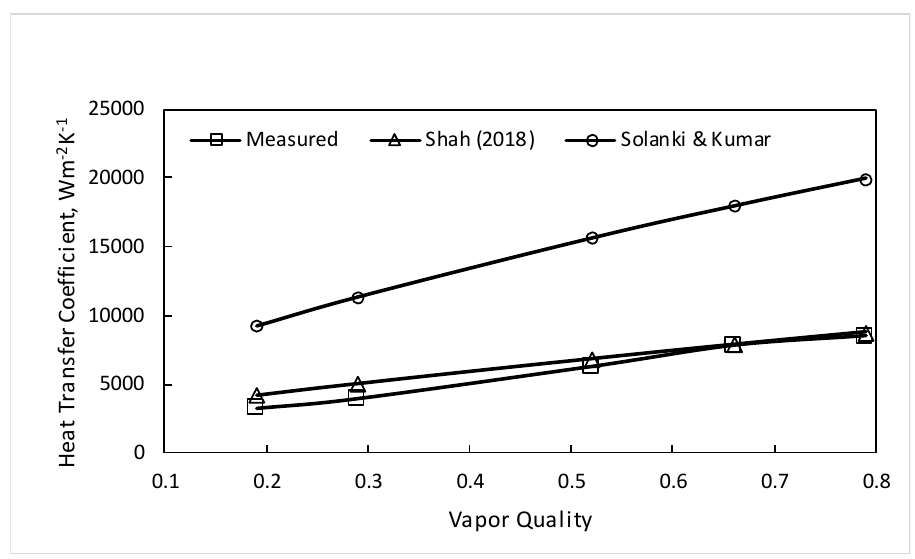
Figure 7. Comparison of the data of Agarwal et al. [46] for barrel shape channels with various correlations. T SAT = 55 C, G = 600 kgm −2 s −1 .